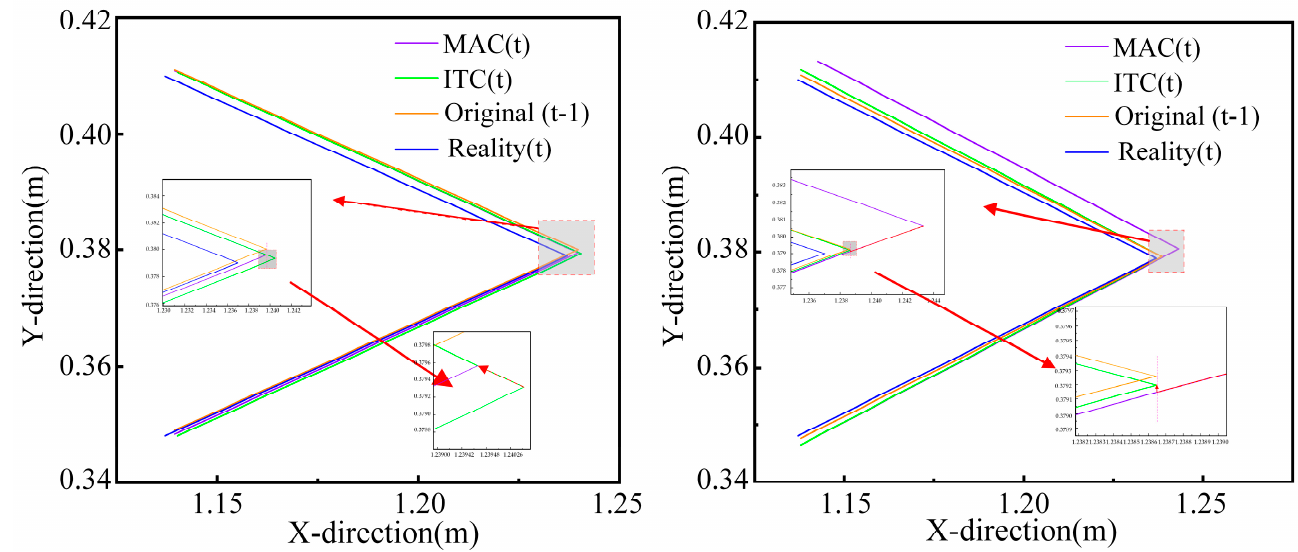
Figure 11. Simulation results of ITC. ( a ) result 1 and ( b ) result